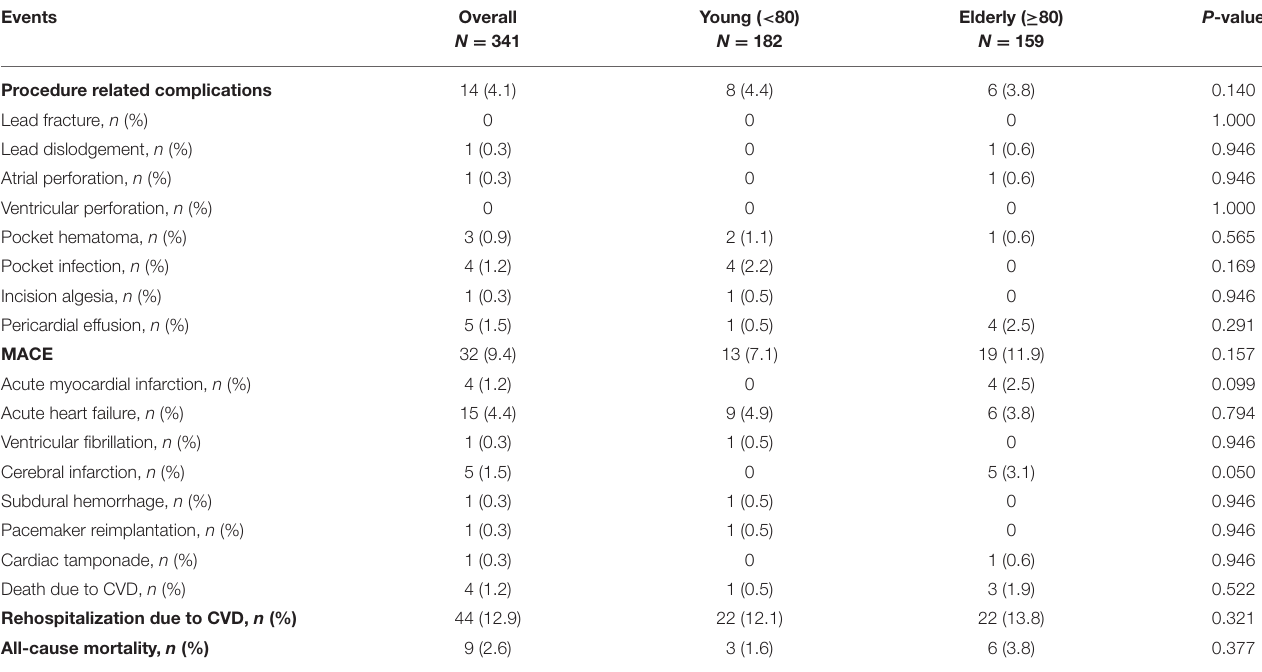
TABLE 3 | Safety and prognosis between younger and elderly